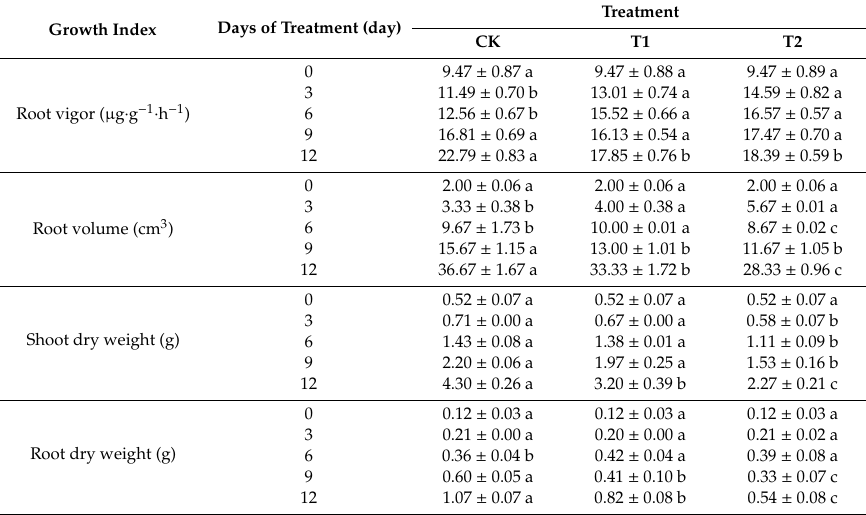
Table 2. Plant growth index of oriental melon under elevated root-zone CO 2